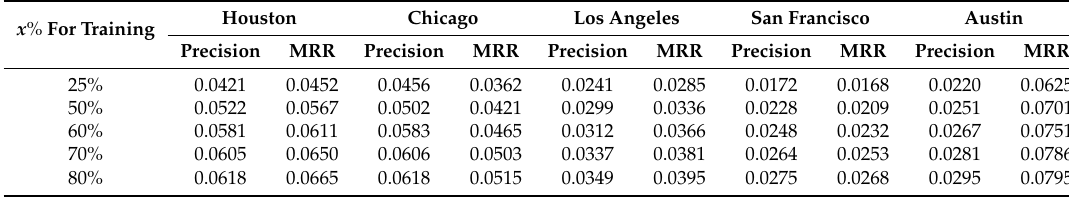
Table 2. Influence of the volume of training data (top-10